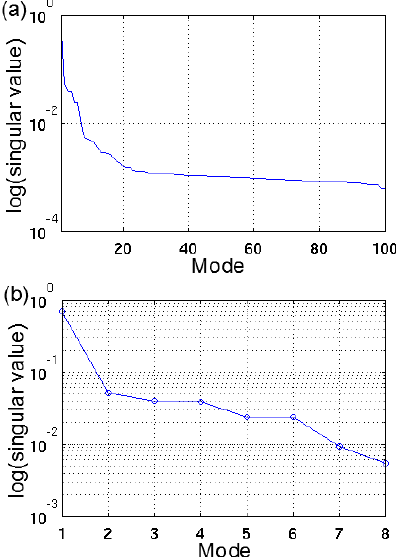
Fig. 7. w-correlation, (a) for the whole components for L SSA =100 and (b) for the first 8 components.